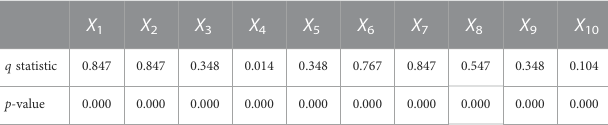
TABLE 5 Detection results of ecological risk factors in Savan